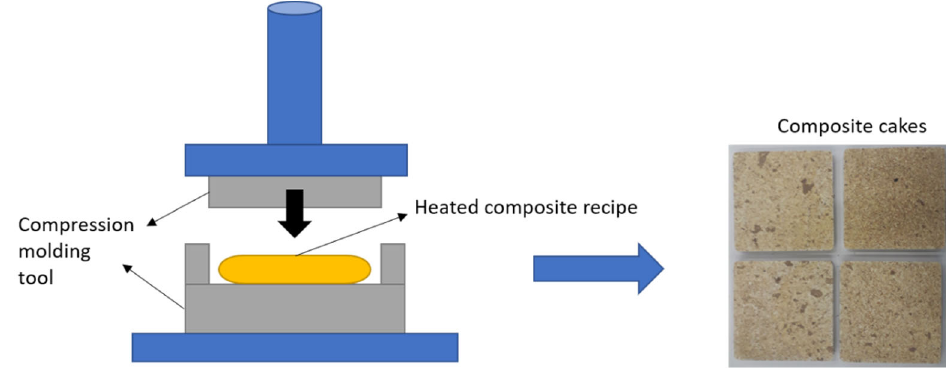
Figure 4. Illustration of the compression molding process.